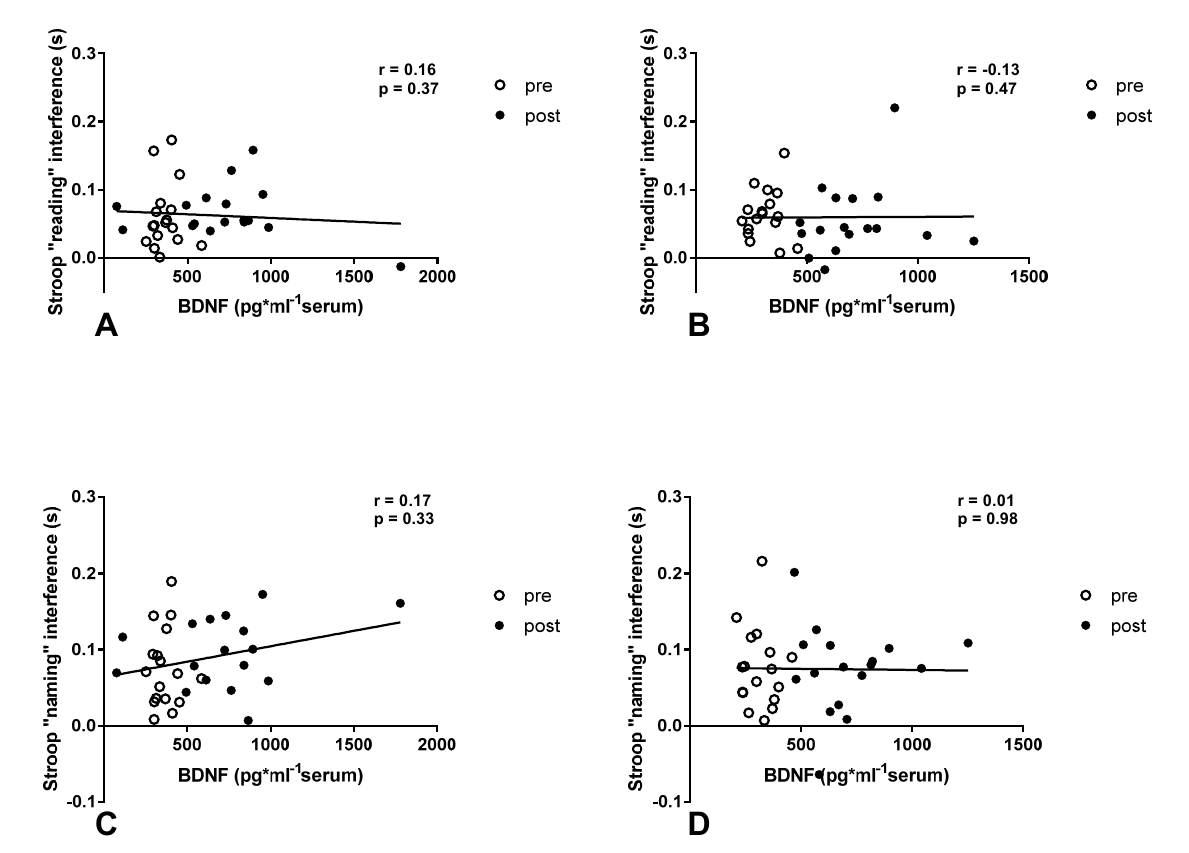
Figure 5. Correlation between Stroop interference and BDNF concentration after acute bout of